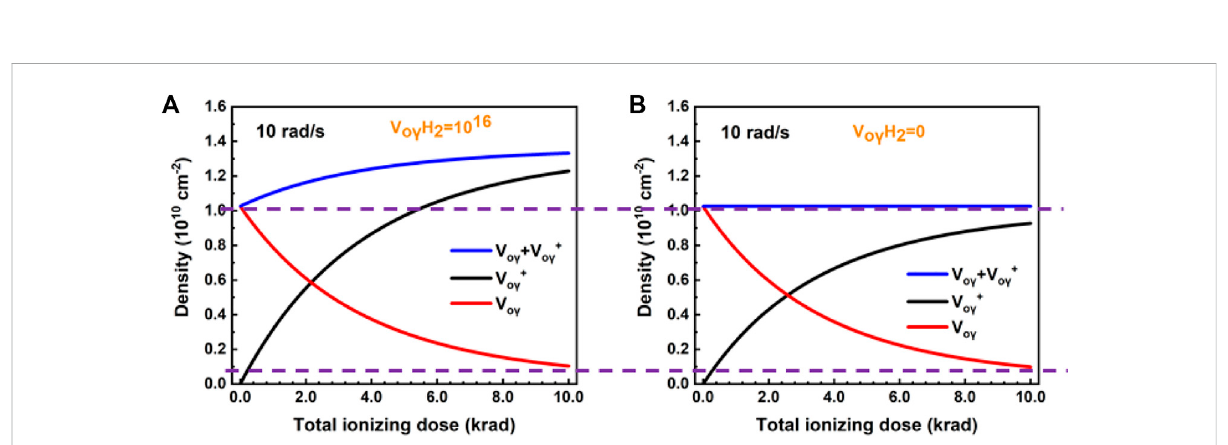
FIGURE 4 Evolution of V + o γ , V o γ and V + o γ + V o γ (A) with and (B) without V o γ H 2 as a function of TID at the dose rate of 10 rad/s at